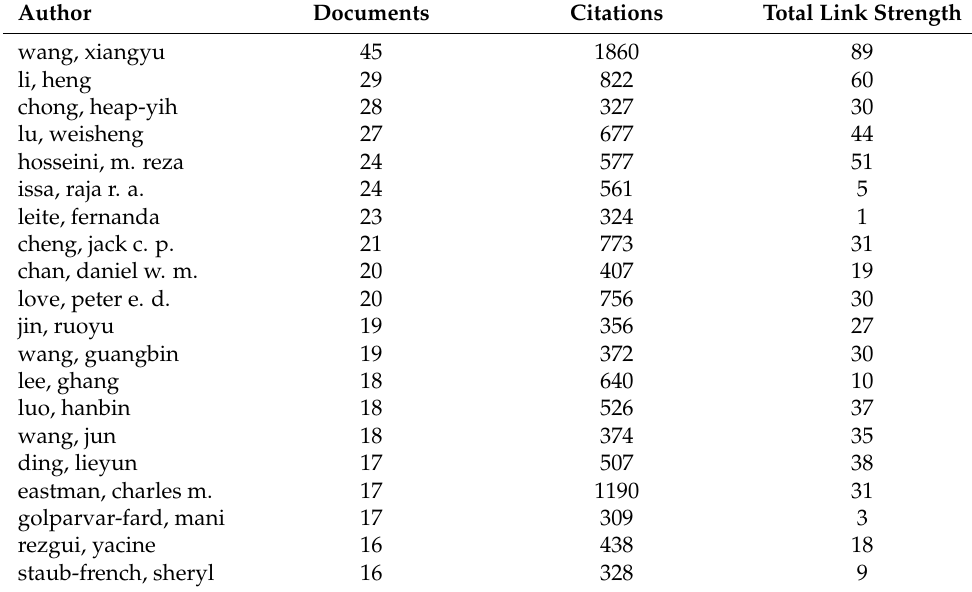
Table 3. Co-citation clusters analysis of building information